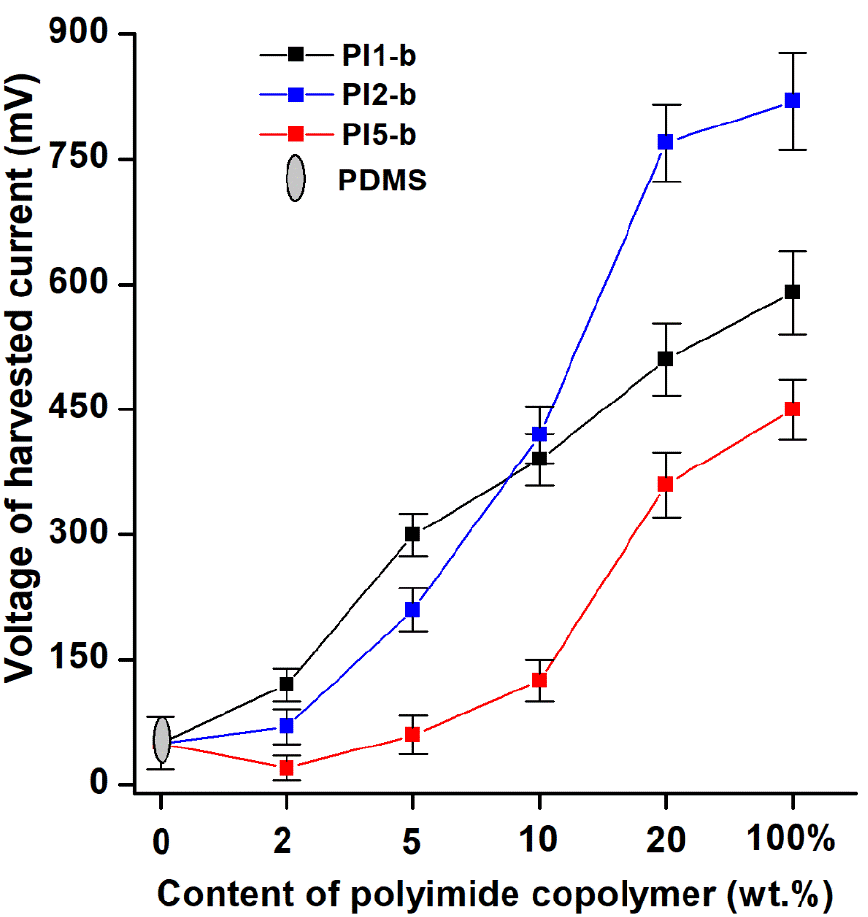
Figure 9. Multiresponse elastomer protective film as a piezoelectric energy harvester and pressure sensor.